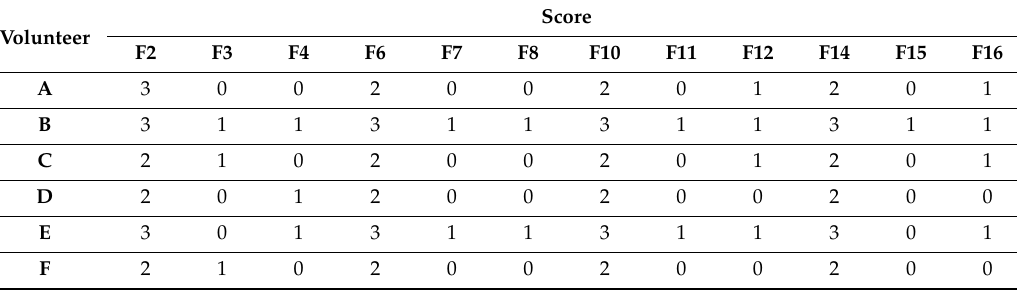
Table 5. Sensory evaluation of designed ODMT formulations, estimated as follows: 0—no bitterness, 1—slightly bitterness, 2—moderately bitterness, 3—significantly bitterness.